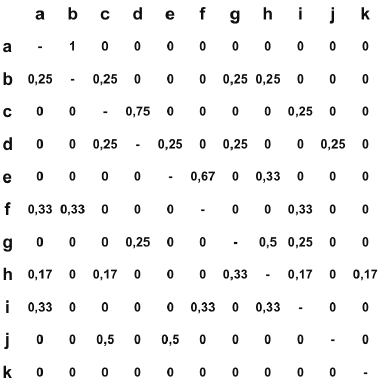
Figure 2. Transition matrix derived from the three observed 10- second stimulus viewings shown in Figure 5